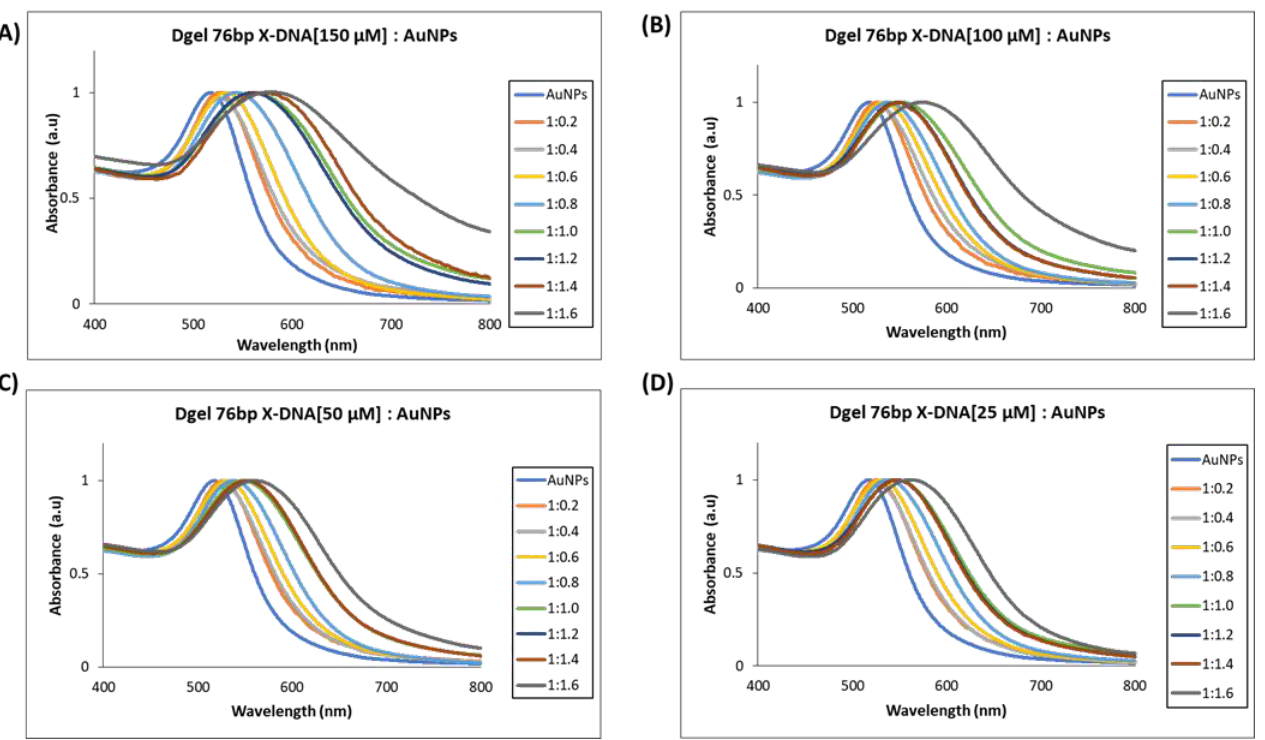
Figure 5. UV visible spectrum analysis of Dgel fabrication with the variations in the concentration of 76 bp X-DNAs, whereas AuNPs concentration and ratios were constant, respectively. ( A ) Dgel (76 bp X-DNA [150 µM]: AuNPs), ( B ) Dgel (76 bp X-DNA [100 µM]: AuNPs), ( C ) Dgel (76 bp X-DNA [50 µM]: AuNPs), ( D ) Dgel (76 bp X-DNA [25 µM] AuNPs).